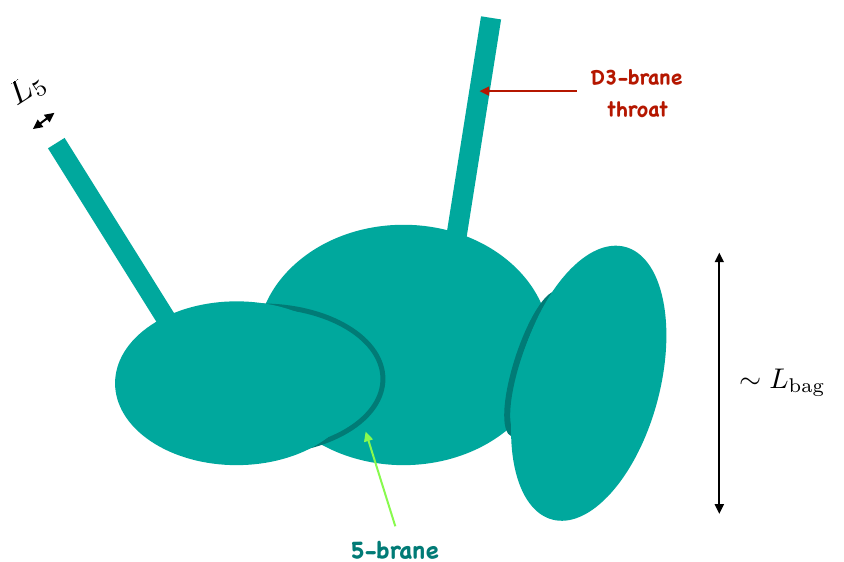
Figure 1 . The ‘bagpipes’ manifold M 6 consists of semiin(cid:12)nite pipes with cross-sectional radius L 5 , attached to a compact bag of typical size (cid:24) L bag (cid:29) L 5 . The dark curves on the bag depict 5-brane singularities. The AdS 4 scale factor diverges at in(cid:12)nity in the pipes so that the full 10 d geometry asymptotes to (AdS 5 = Z 2 ) (cid:2) S 5